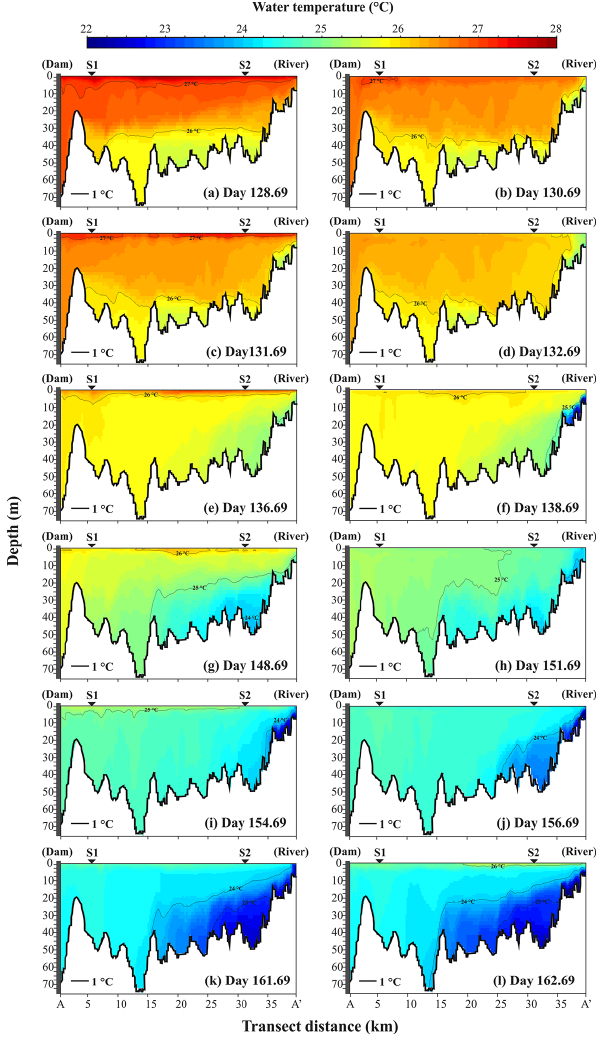
Figure 7. Changes in the thermal structure of the Itumbiara Reser- voir along its longitudinal (AA’) transect (a–l) . The AA’ transect location is shown in Fig. 1.